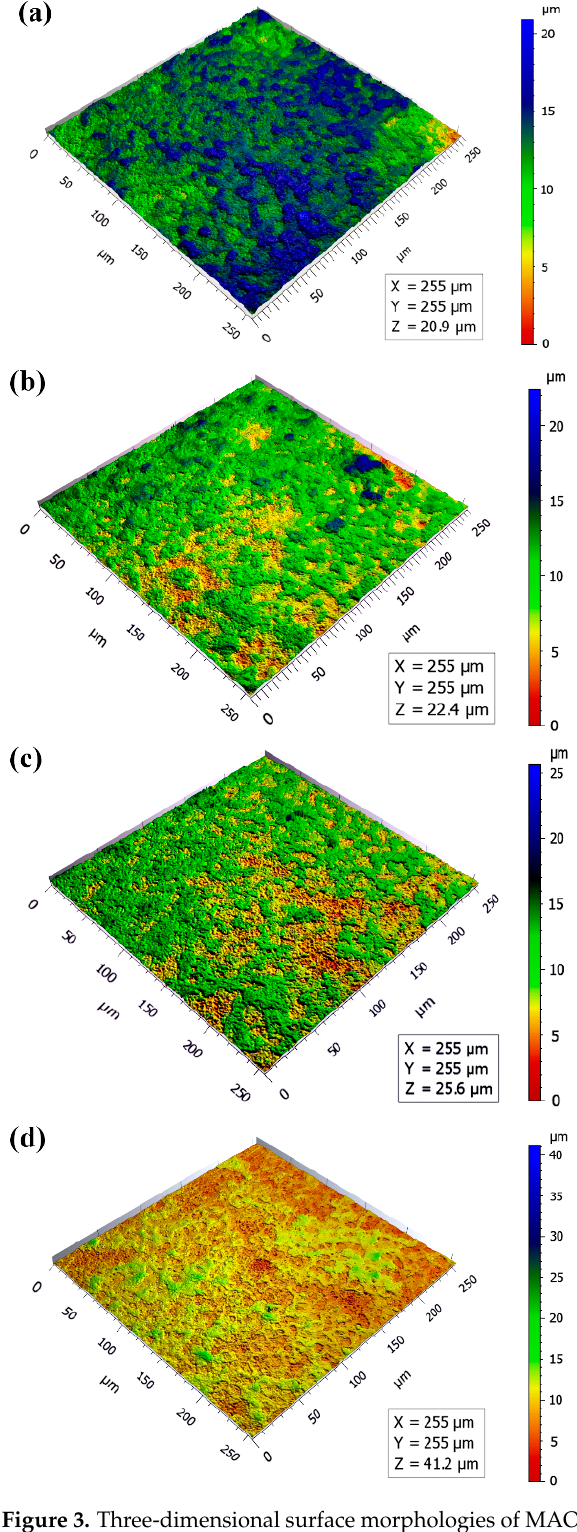
Figure 3. Three-dimensional surface morphologies of MAO coatings: ( a ) 5 min; ( b ) 10 min; ( c ) 15 min; ( d ) 20 min.